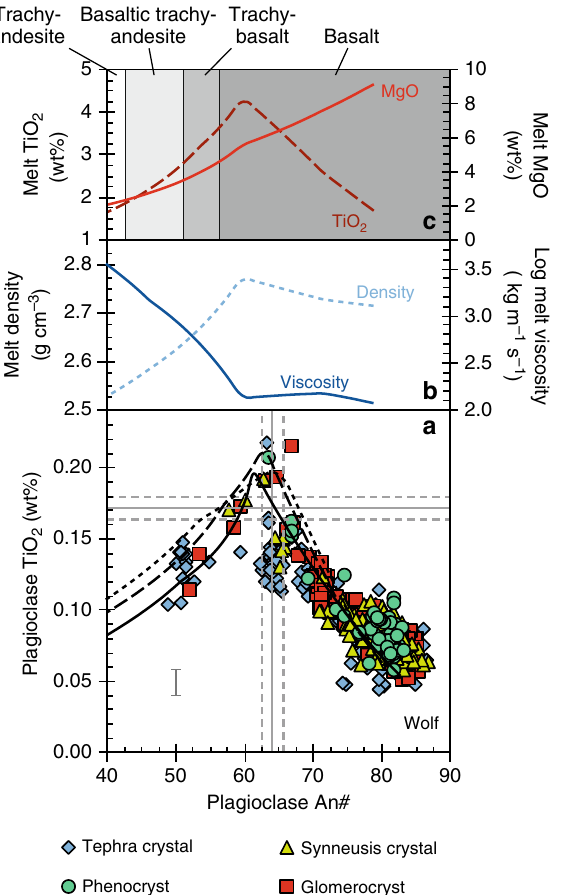
Fig. 8 TiO 2 in plagioclase model for the 1968 Fernandina eruption. a Plagioclase TiO 2 vs. An# in nodule samples from the 1968 Fernandina eruption and lava samples from historic Fernandina eruptions. Crystals are classi fi ed according to their textural association (see legend). Crystal compositions from historic Fernandina lavas are from Allan and Simkin 28 . Characteristic 2 σ analytical uncertainty for our plagioclase analyses is shown for TiO 2 and is less than the size of a data point for An#. The grey lines show the compositions of crystals calculated to be in equilibrium with the 1968 Fernandina scoria glass 28 , using the models of Namur et al. 67 for An# and Nielsen et al. 43 for TiO 2 at 1130 °C (the approximate pre-eruptive crystallisation temperature) 28 . The black lines show the trajectory of plagioclase compositional evolution calculated using Rhyolite-MELTS and the TiO 2 partitioning model of Nielsen et al. 43 at 50 MPa (solid line), 300 MPa (dashed line) and 500 MPa (dotted line). Plagioclase comes onto the liquidus at 1191, 1207 and 1222 °C in 50, 300 and 500 MPa models, respectively. The plots above show b the physical and c the compositional evolution of the liquid predicted by Rhyolite-MELTS at 500 MPa (the approximate crystallisation pressure at Fernandina) 34 .